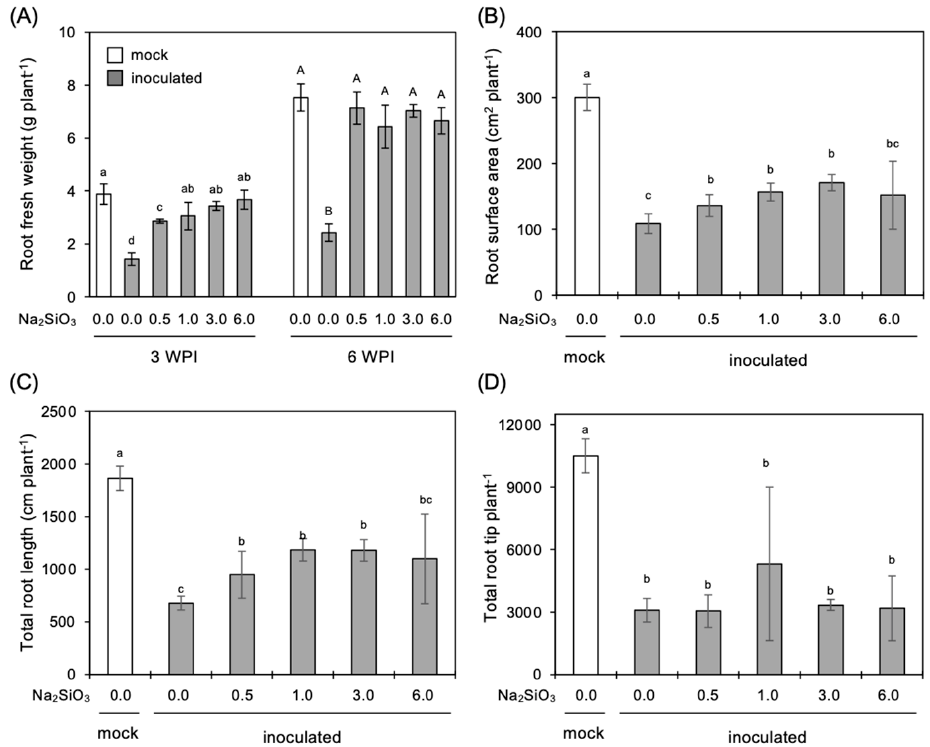
Figure 4. Root FW at 3 and 6 WPI ( A ), root surface area ( B ), total root length ( C ), and total number of root tips ( D ) of soybean plants at 3 WPI ( n = 12). Different lowercase letters at each sampling time point indicate significant difference ( P < 0.05), as per Tukey’s HSD test.